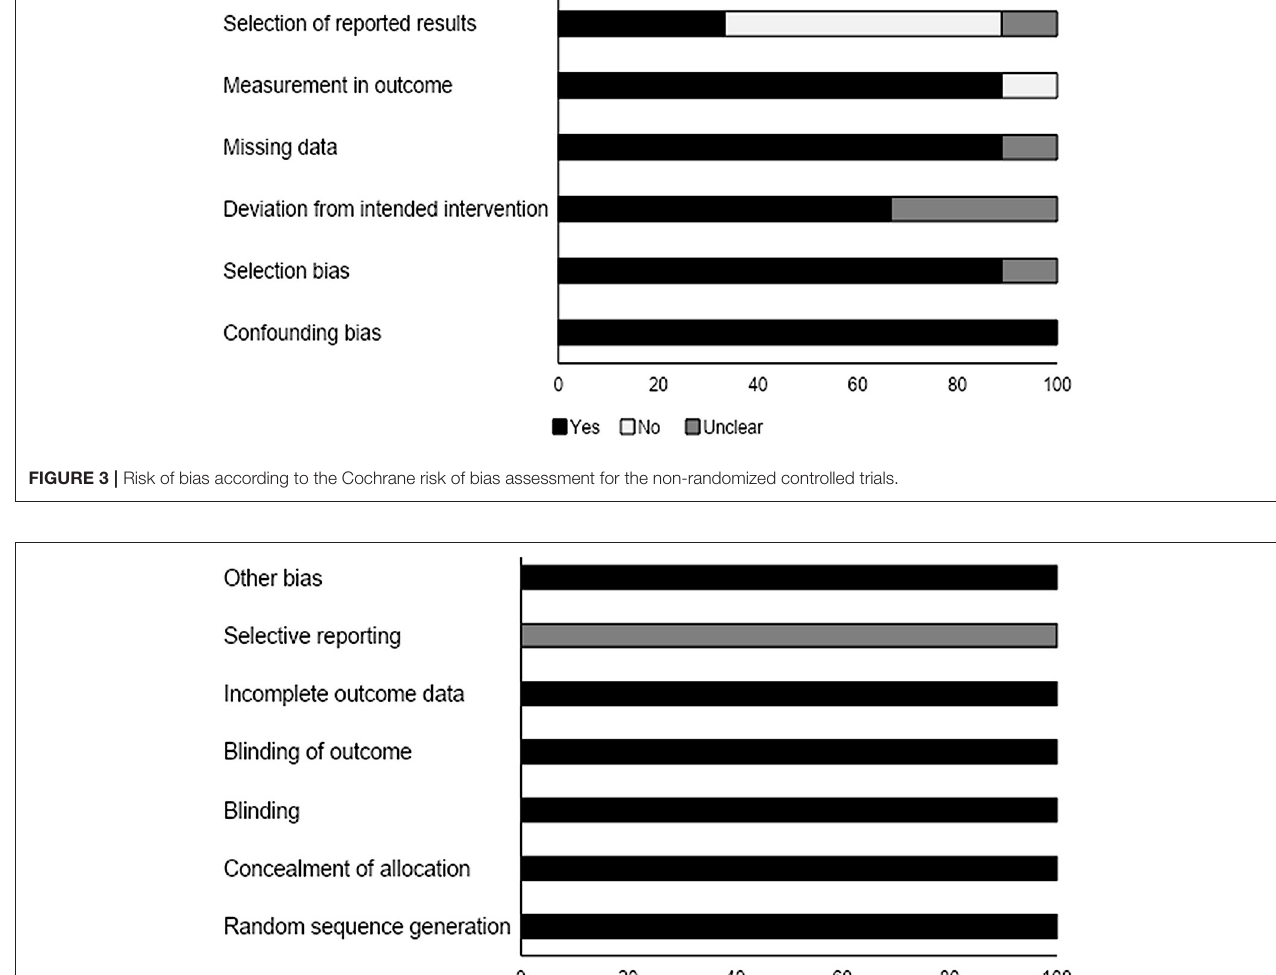
TABLE 4 | Risk of bias within studies according to the Cochrane risk of bias assessment tool for randomized controlled trials. Study Random